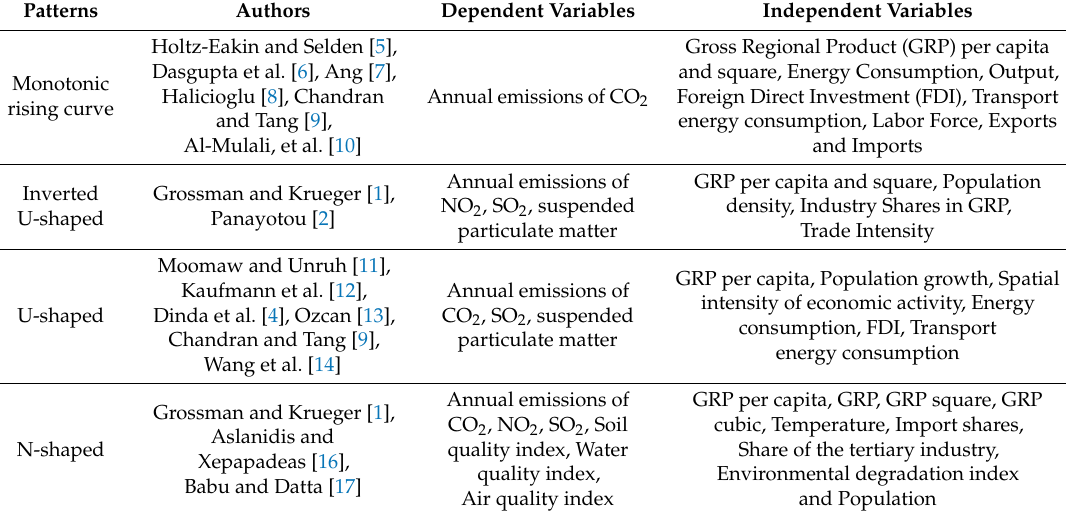
Table 1. Reviews on the Relationship between Economic Growth and